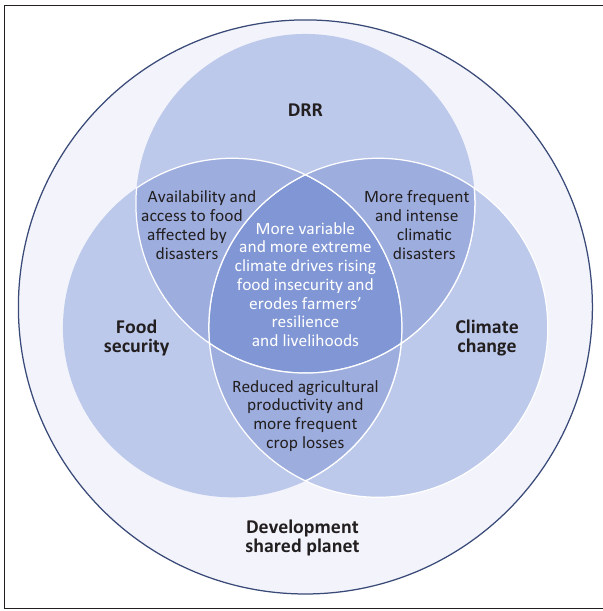
FIGURE 1: Disaster risk reduction, climate change adaptation and food security